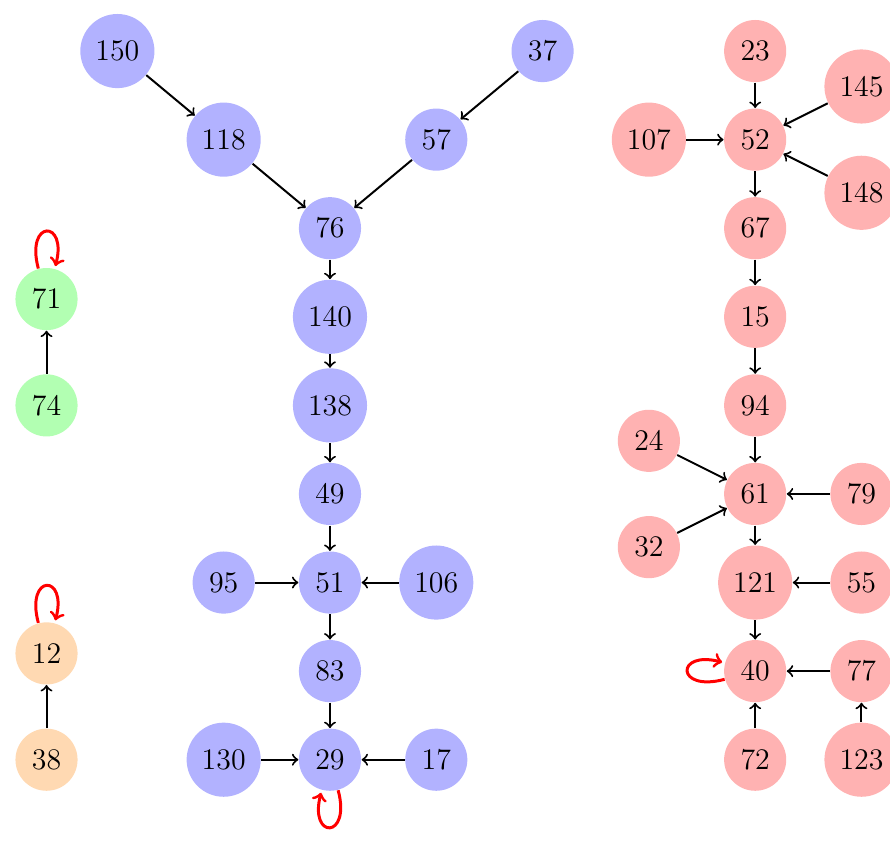
Figure 2: 4 components containing cycles of length